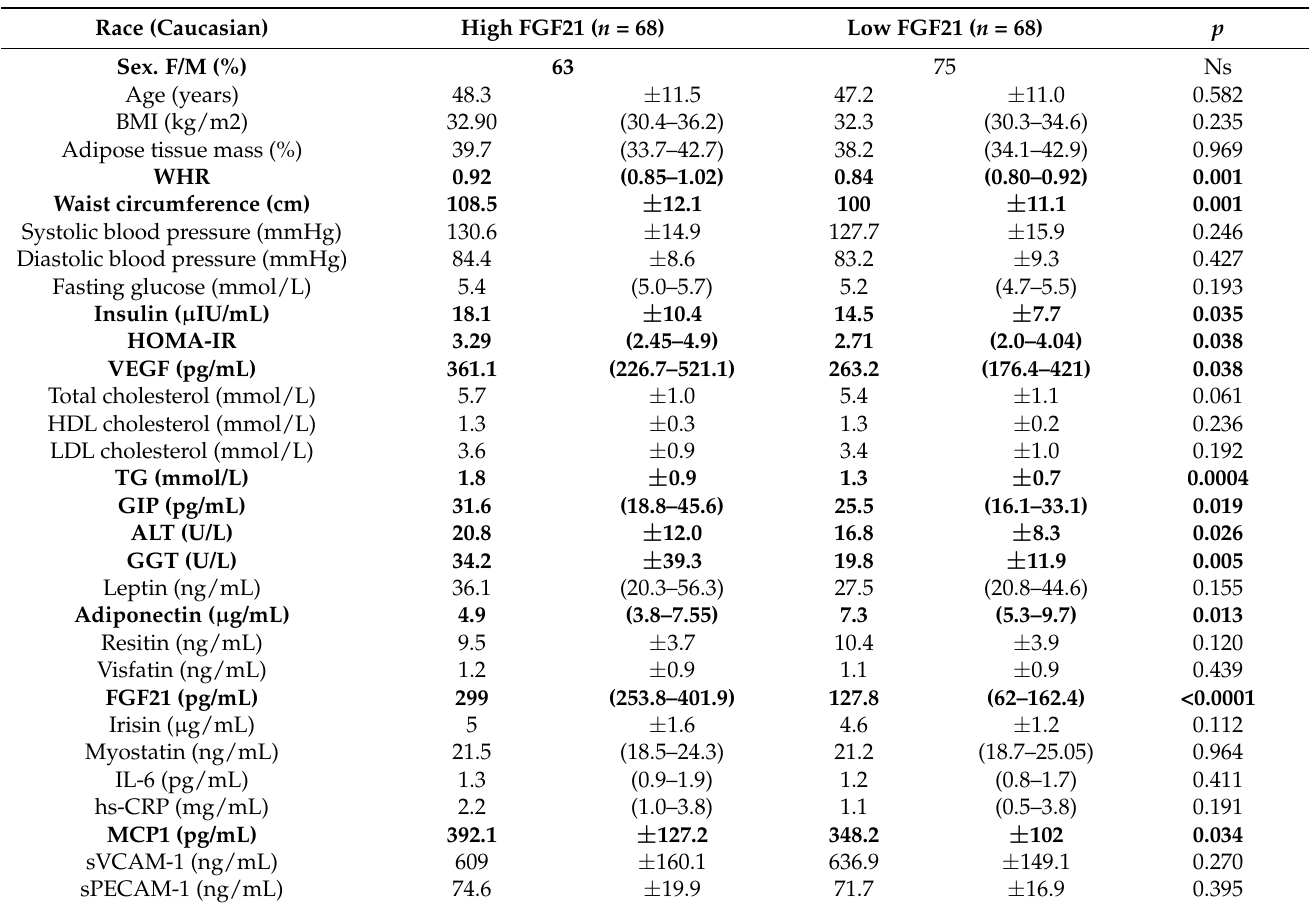
Table 1. Characteristics of